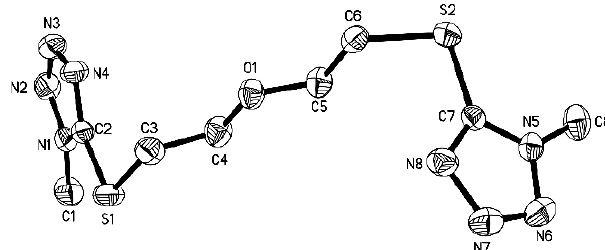
Table 1. Data collection and handling.